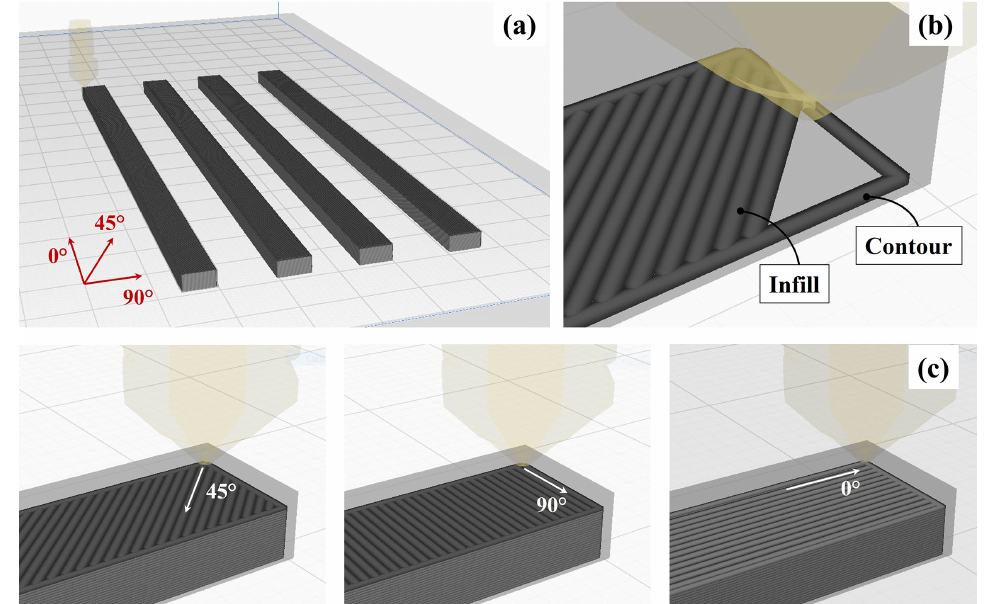
Figure 1. Schematic representation of specimens geometry ( a ), contour and infill lines ( b ) and considered printing direction ( c